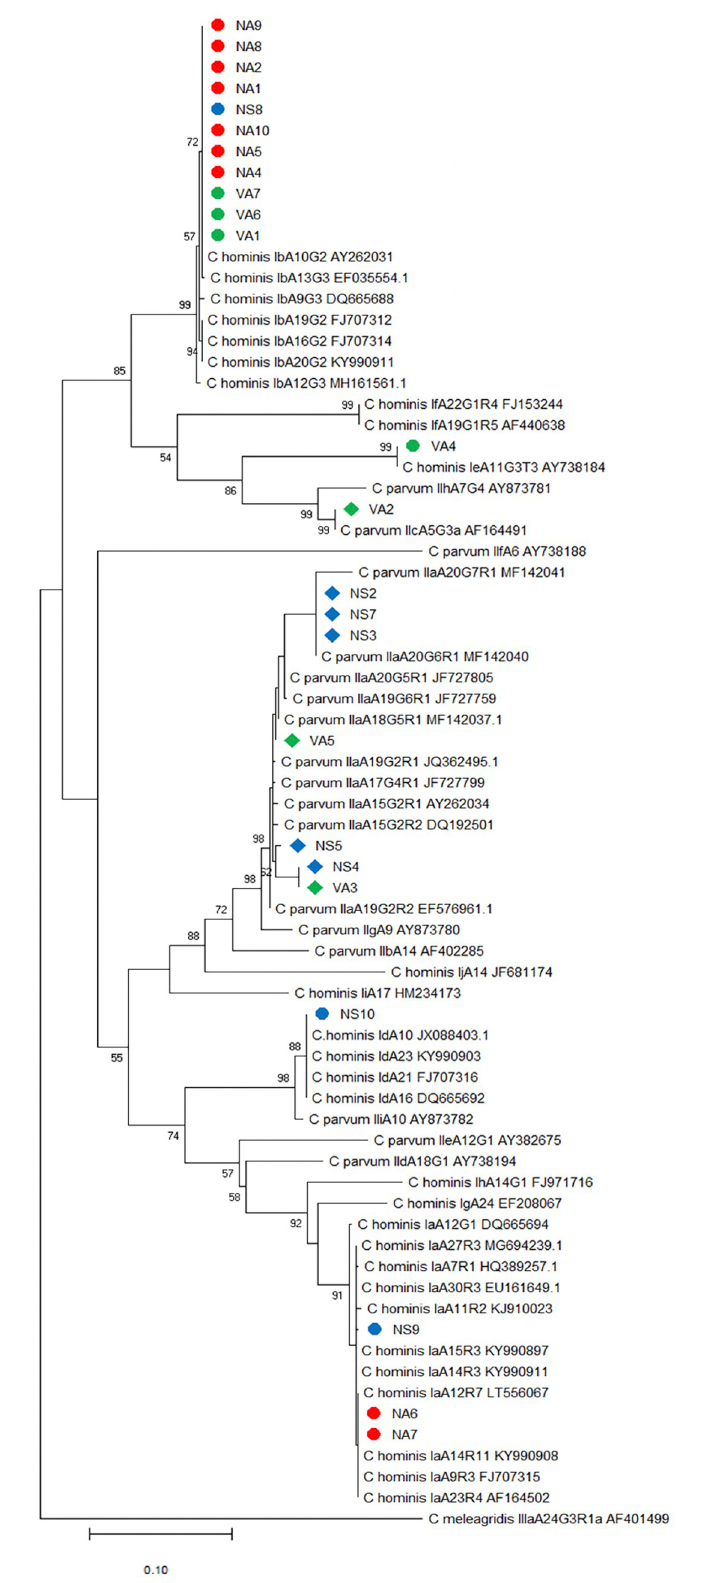
Fig 2. Phylogenetic relationships of Cryptosporidium hominis and C . parvum at the gp60 locus. https://doi.org/10.1371/journal.pone.0270995.g002 PLOS ONE | https://doi.org/10.1371/journal.pone.0270995 July 8,